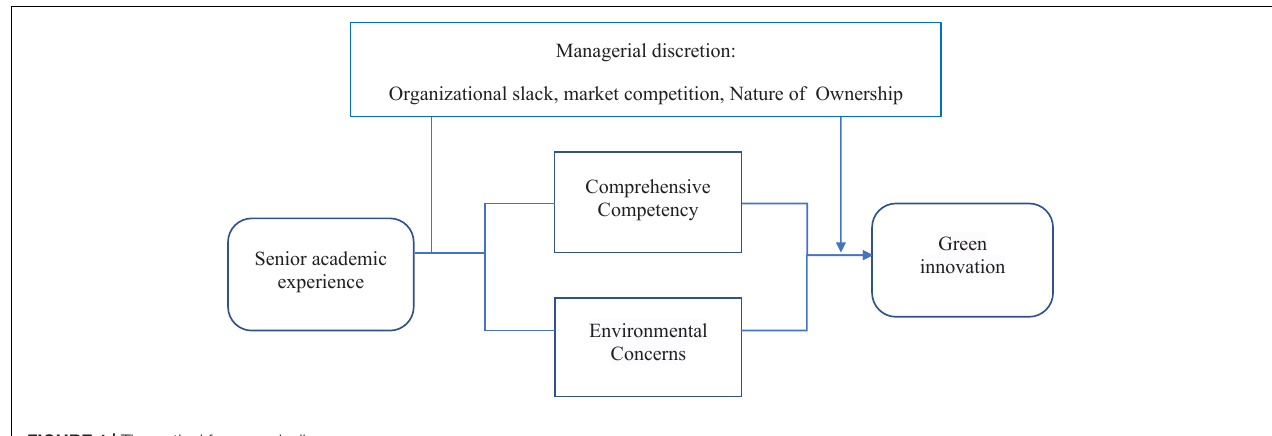
FIGURE 1 | Theoretical framework